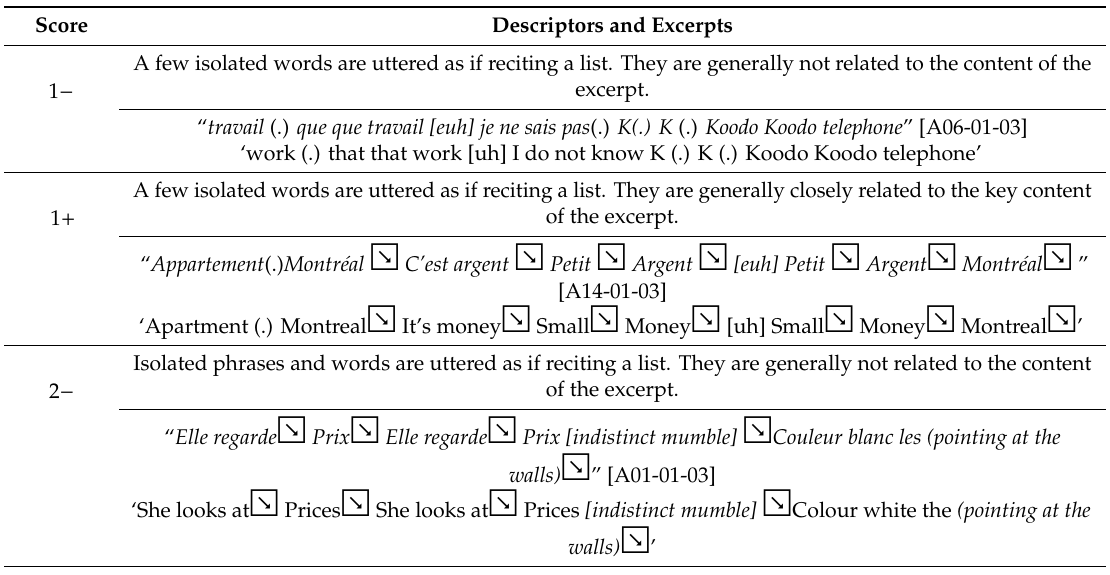
Connected phrases are uttered. The connexions established by the participants are generally closely related to the key content of the excerpt. Connected phrases are uttered in the form of a (partial) narration. The content of the (partial) narration is generally closely related to the key content of the excerpt. Connected phrases are uttered in the form of a (partial) narration. The content of the (partial) narration is not entirely related to the content of the excerpt.